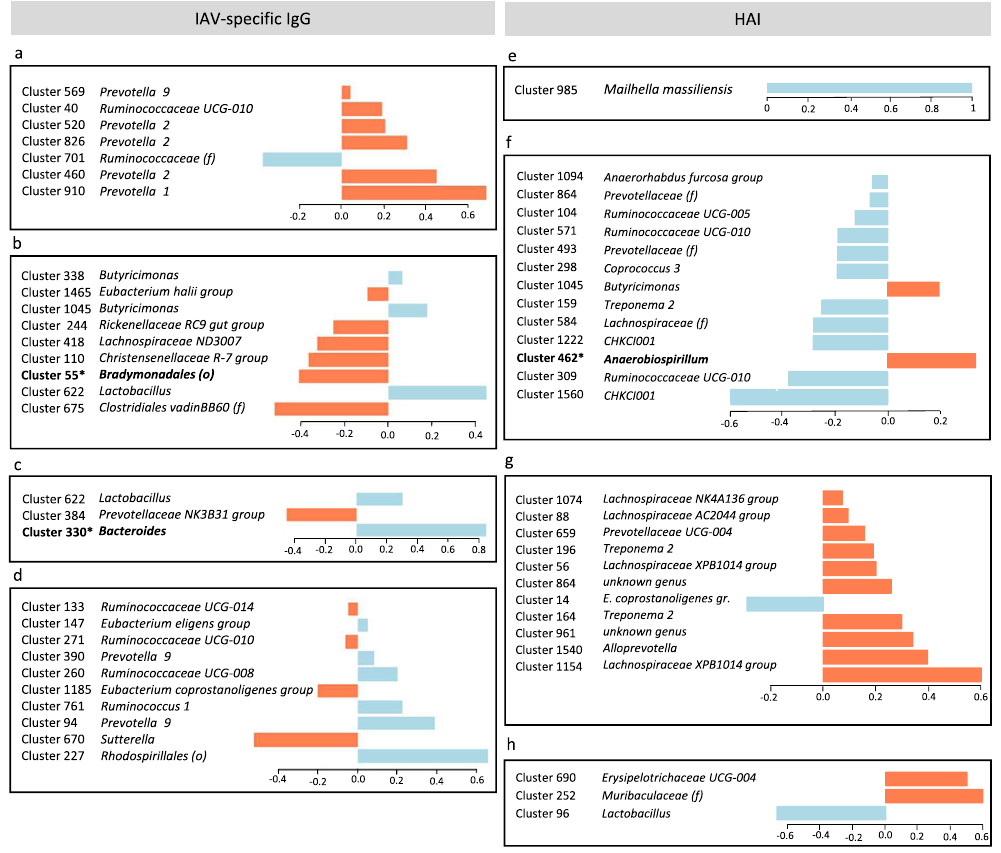
Fig. 6 Loading plots representing the speci fi c contribution of OTUs to the prediction of vaccine response. The OTUs were selected by sPLS-DA (data available in Supplementary Data 8). The color of each bar indicates the group of pigs in which that OTU had a higher mean relative abundance: orange for high responders and blue for low responders. a – d Contributions of OTUs to the fi rst component are displayed for the analysis of IAV-speci fi c IgG levels at a D49, b D56, c D63, and d D146. e – h Contributions of OTUs to the fi rst component are displayed for the analysis of HAI titers at e D49, f D56, g D63, and h D146. OTU annotation is indicated at the genus level and, where not available, at the family (f) or order (o) levels. Asterisks indicate the few OTU that were differentially abundant between high and low responders at the same time points